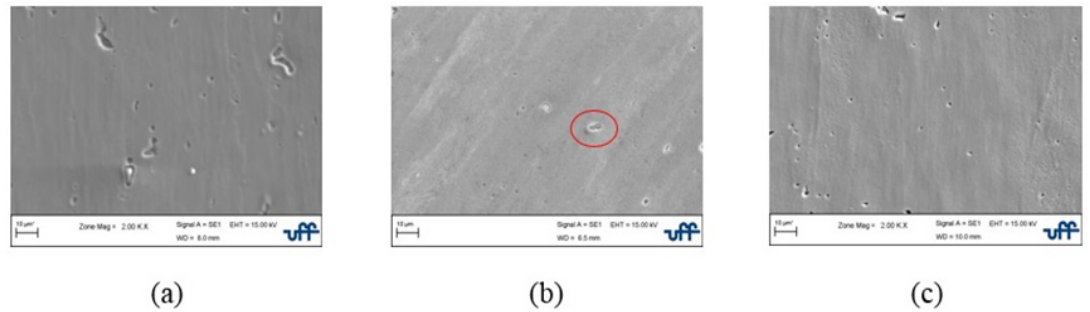
Figure 3. Microstructure analyzed by MEV, SE mode 2000x magnification, Keller 20s attack: a) 1st pass at 180ºC b) 2nd pass at 130ºC, c) 2nd pass at